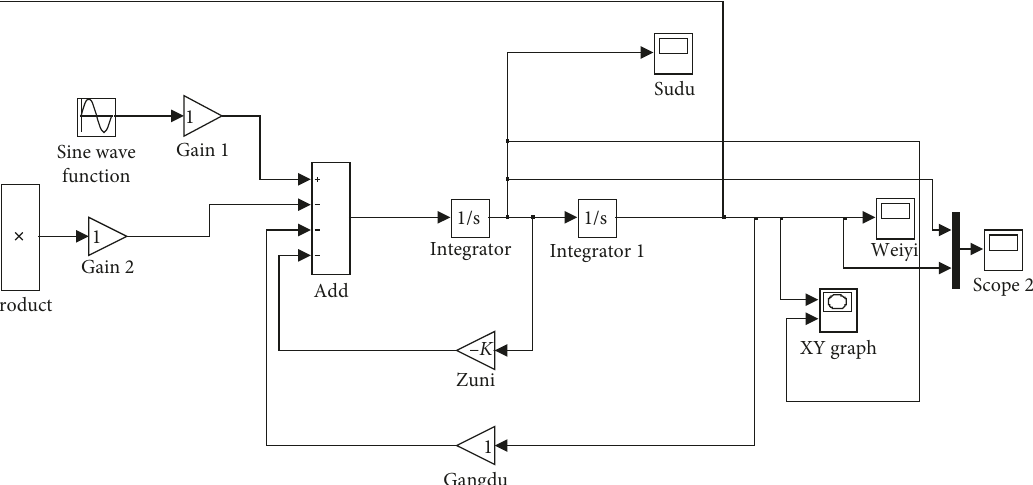
Figure 5: Simulated model of the system.